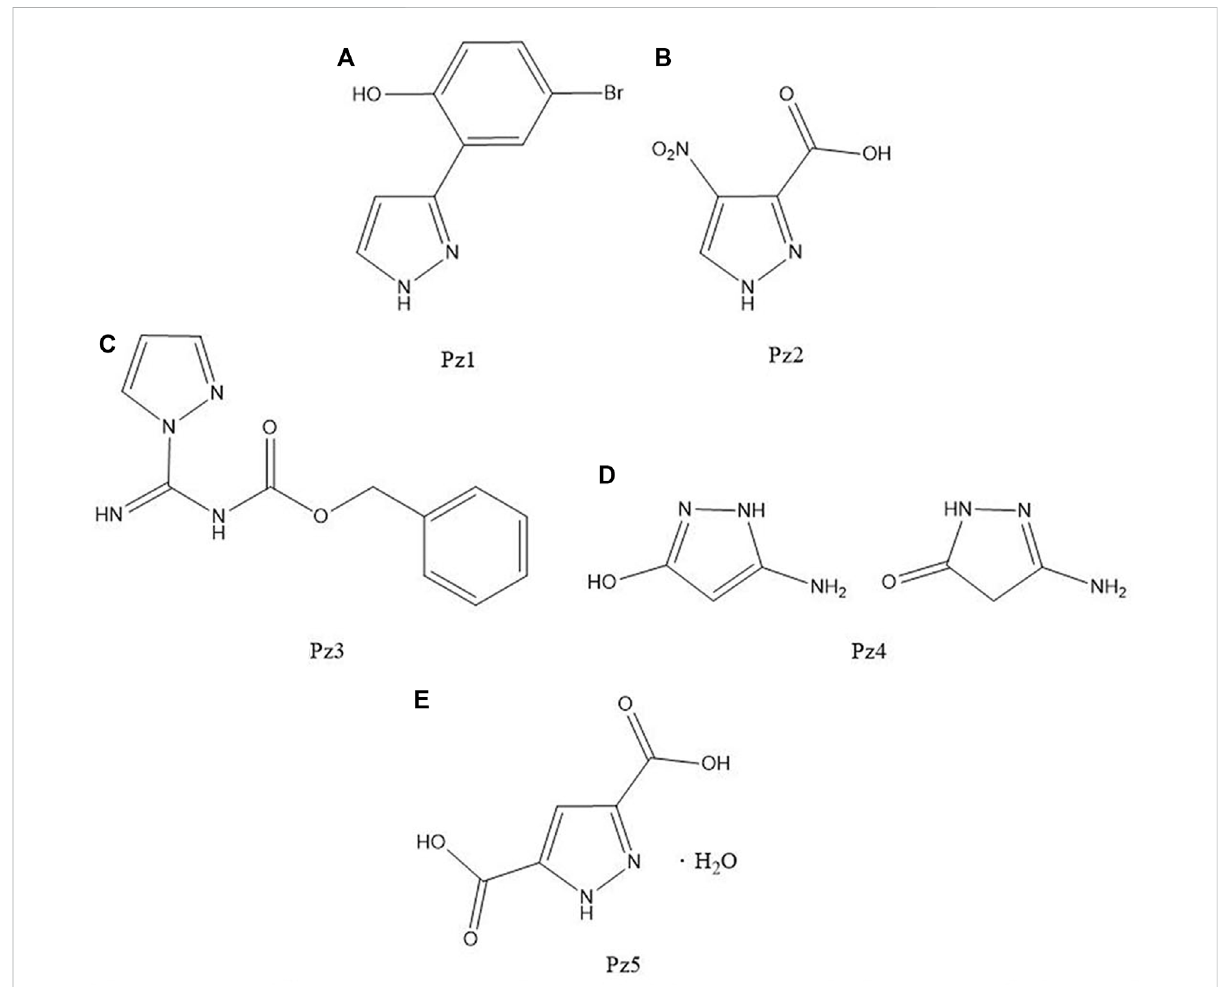
Structure of (A) 4-bromo-2-(1H-pyrazol-3-yl)phenol, (B) 4-nitro-3-pyrazolecarboxylic acid, (C) N-(benzyloxycarbonyl)-1H-pyrazole-1- carboxamidine, (D) 3-amino-5-hydroxypyrazole, and (E) 3,5-pyrazoledicarboxylic acid